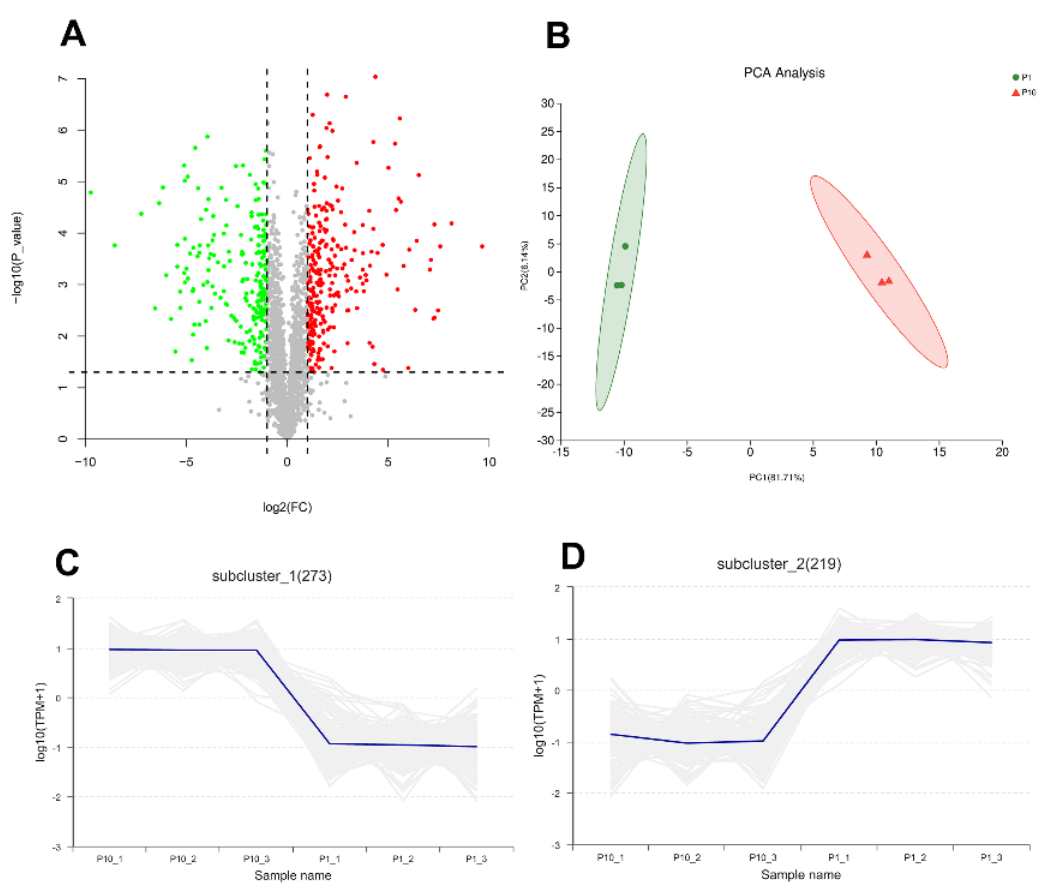
Figure 1. Overview of the proteomic result. The volcano plot ( A ) showed 277 up-regulated differentially expressed proteins (DEPs) and 224 down-regulated DEPs. Principal component analysis (PCA) ( B ) showed good repeatability of each biological replicate. Consistent expression trend of 273 proteins in up-regulated DEPs ( C ), and 219 proteins in down-regulated DEPs ( D ).